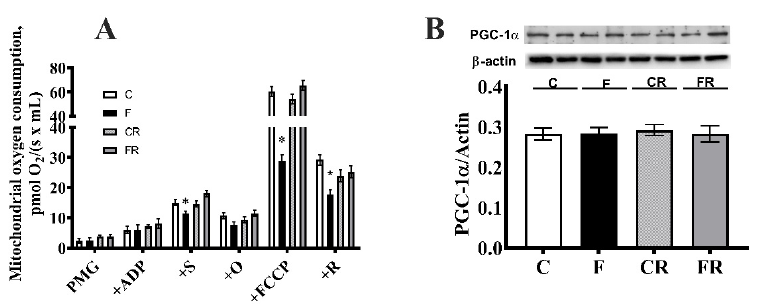
Figure 4. Mitochondrial function. ( A ) Non-normalized respiration after the addition of pyruvate + malate+ glutamate (PMG), ADP, succinate (S), oligomycin (O), FCCP, and rotenone (R), ( B ) PGC-1alpha concentration (with representative Western blot) in the hippocampi from control (C), fructose-fed (F), control-rescued (CR), and fructose-rescued (FR) rats. Values are the means ± SEM of eigth different rats. * p < 0.05, compared to C rats (One-way ANOVA followed by Tukey’s post-test). Data are the means ± SEM of eight different rats. * p < 0.05 compared to